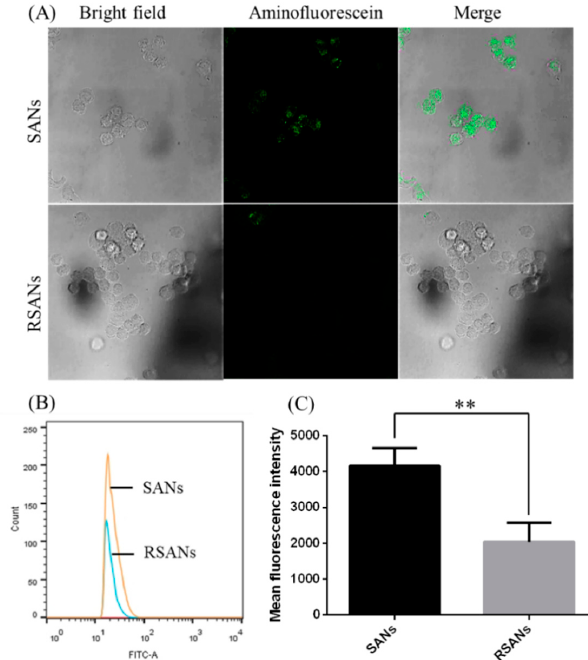
Figure 6. Cellular uptake of SANs and RSANs on RAW 264.7 macrophages. ( A ) Confocal image 630×. The SANs were labeled with 5(6)-Aminofluorescein (green), ( B ) Fluorescence intensity detection by flow cytometry. ( C ) Quantitative analysis of the fluorescence intensity. Data are shown as ± SD of the mean ( n = 3). ** correspond to p <